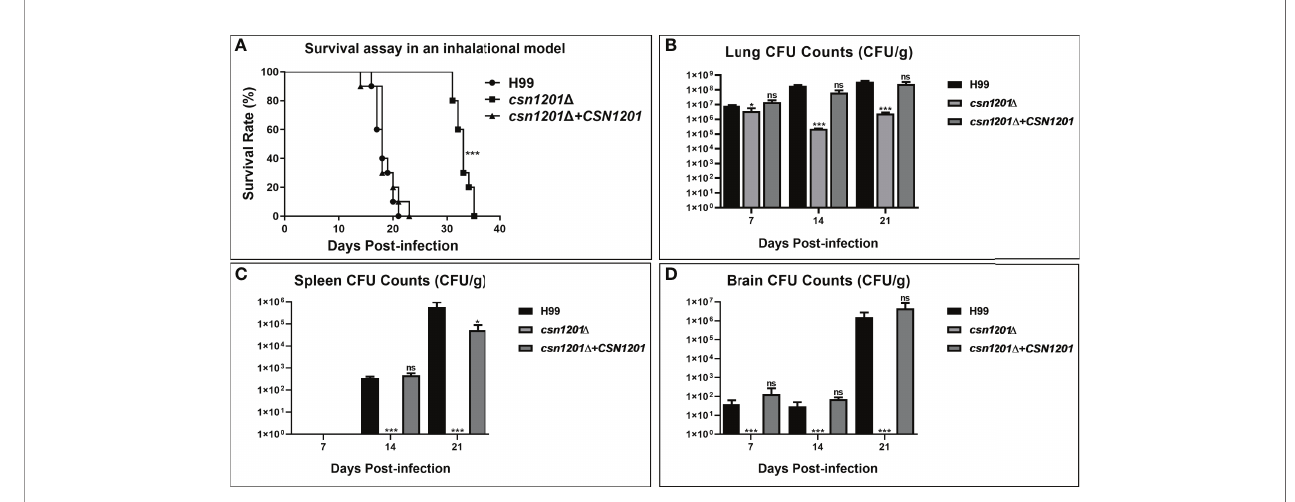
FIGURE 4 | Csn1201 is essential for C. neoformans virulence in mouse inhalational infection models. (A) Survival assay in an inhalational model. Mouse lung (B) , spleen (C) , and brain (D) fungal burden assays were performed by counting fungal colonies after culturing serially diluted tissue lysate on YPD plates.